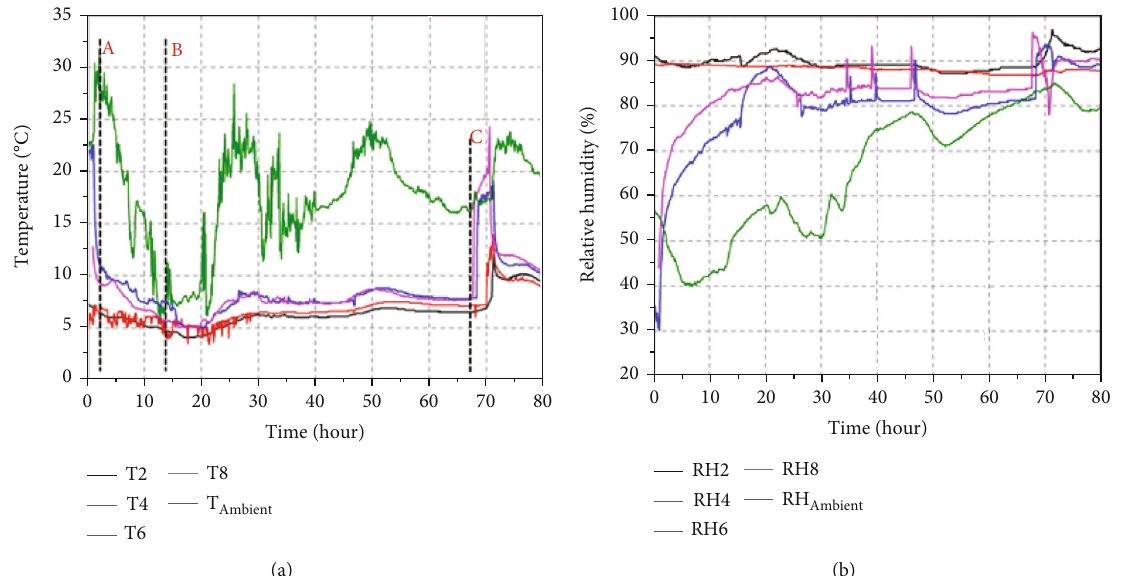
Figure 4: Time evolution of the temperature and RH inside the loaded conditioner under dynamic conditions (axial direction, a: temperature, b: relative humidity).